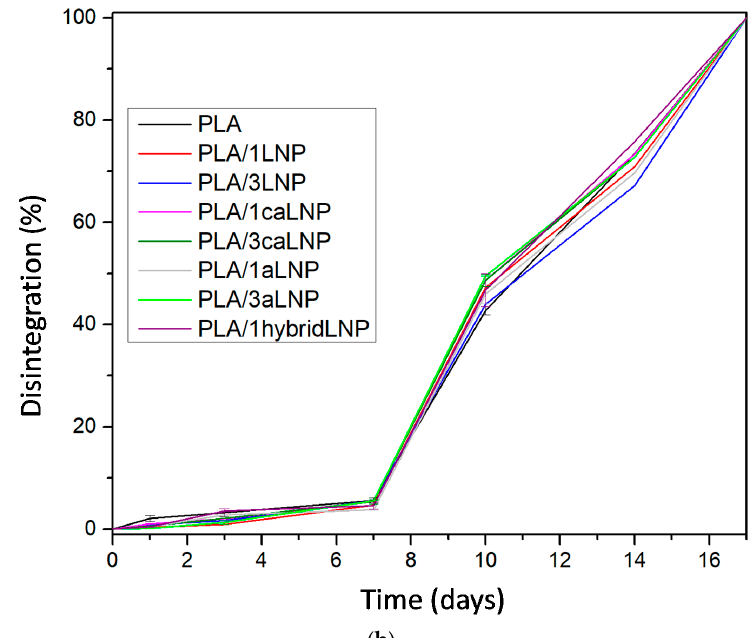
Figure 7. Disintegration of PLA and PLA nanocomposite films in simulated composting conditions (58 °C): ( a ) visual observation and ( b ) disintegration values (wt %).